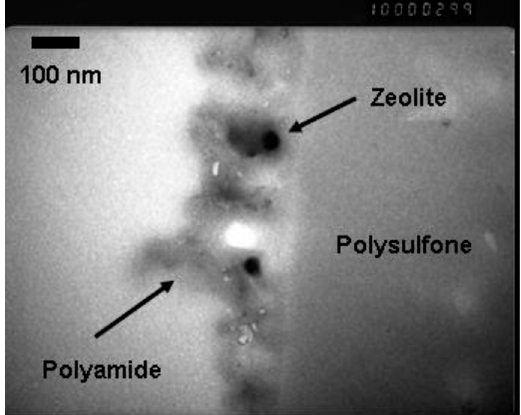
Figure 18. TFN membrane showing zeolite Linde type A imbedded into the polyamide membrane layer [284]. Reprinted with permission of Elsevier B.V.